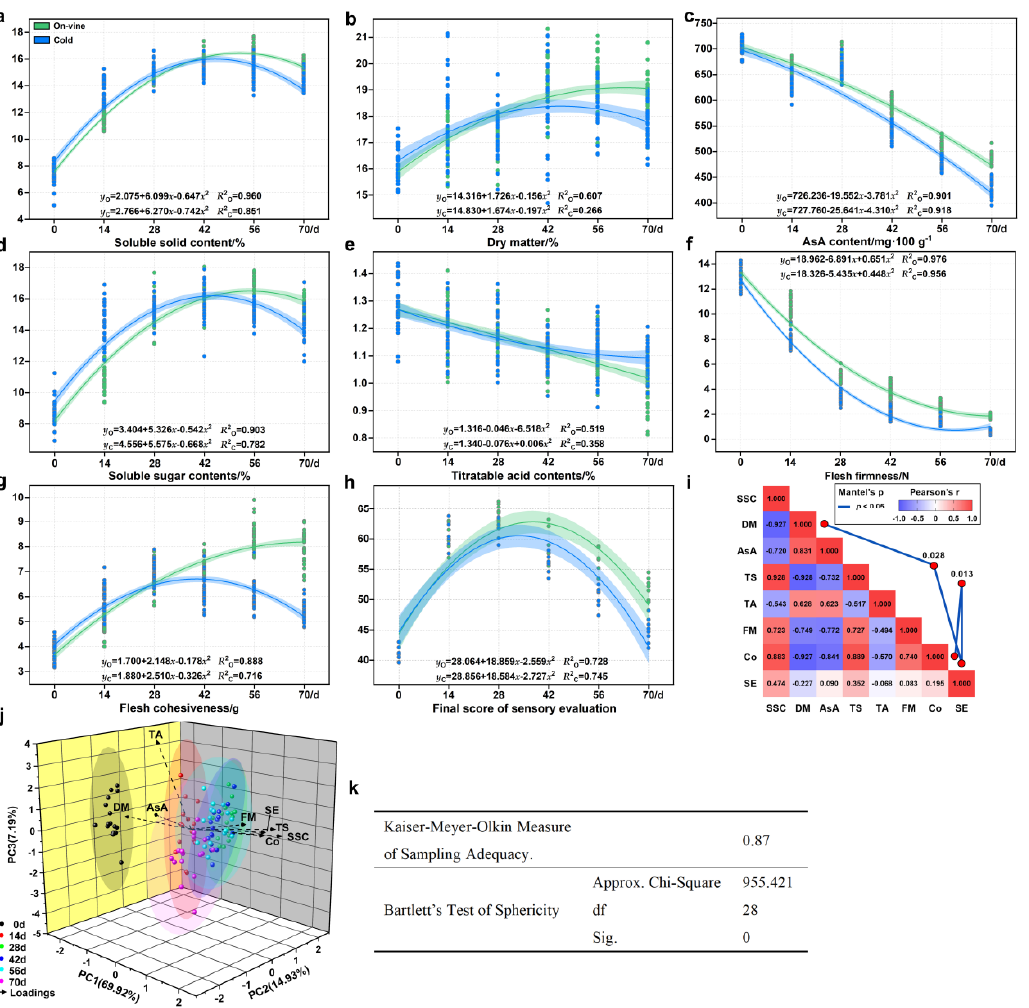
Figure 10. Mathematic and PCA modeling of test indices. ( a – h ) One-letter polynomial equation of regression of 8 test indices. ( i ) Correlation coefficient. ( j ) 3D load diagram of PCA. ( k ) Result of KMO and Bartlett’s Test.